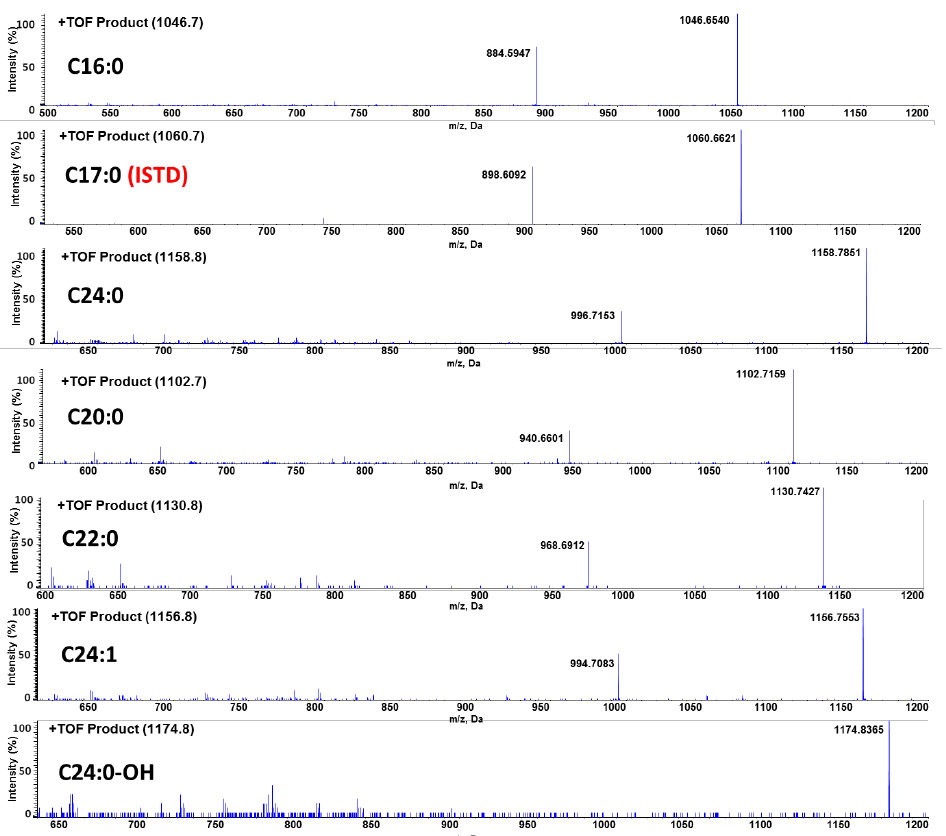
Figure 3. Product ion mass spectra of six GB3 isoforms and internal standard (ISTD).